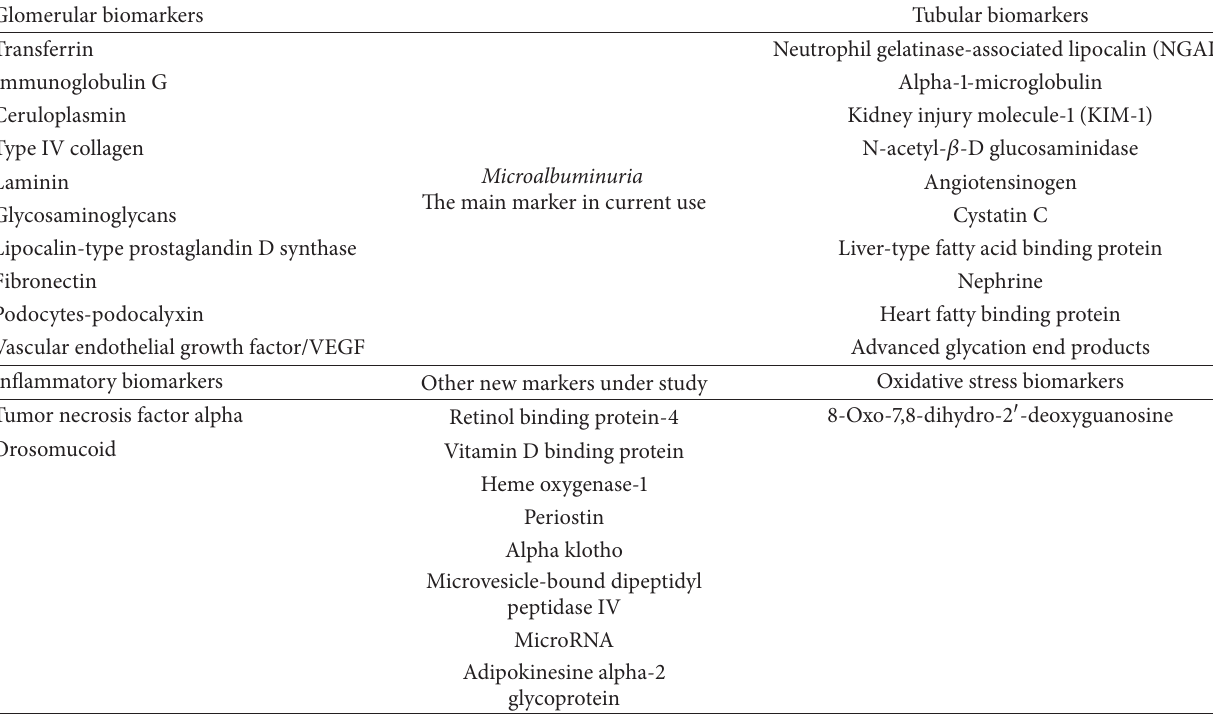
Table 1: Urinary biomarkers in the assessment of early diabetic